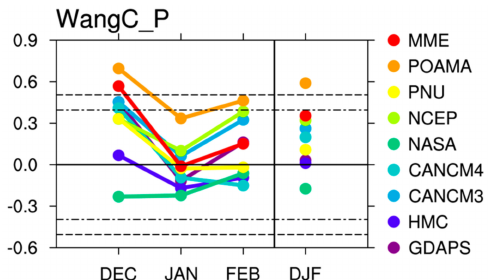
Figure 8. Correlation coefficients between the simulated and observed normalized DJF mean EAWM index and those based on monthly values within the whole December–February period. Dashed lines denote the threshold values for the 95% and 99% significance levels.